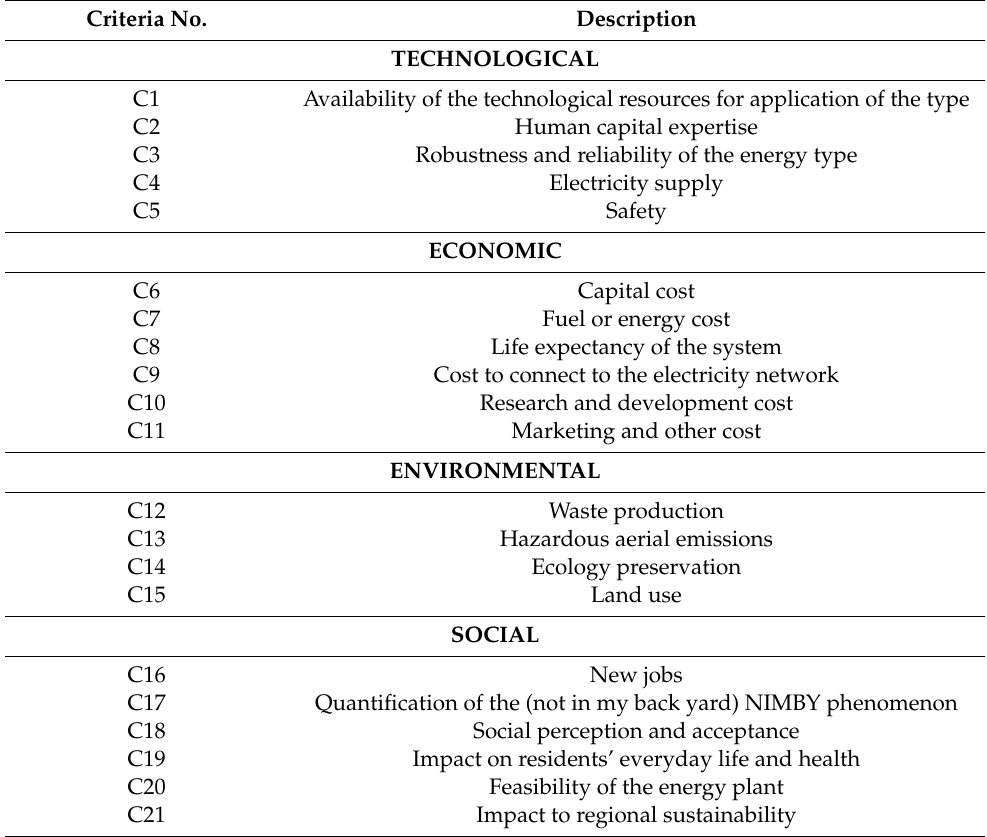
Table 4. Expert stakeholder criteria setup for the energy type selection. Criteria